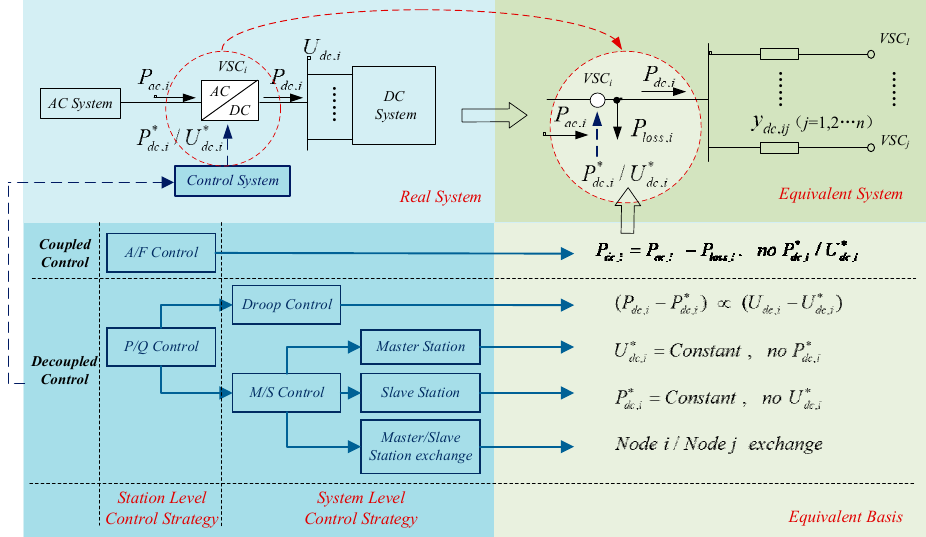
Figure 5. The equivalent relationships according to various control strategies for VSC-MTDC.